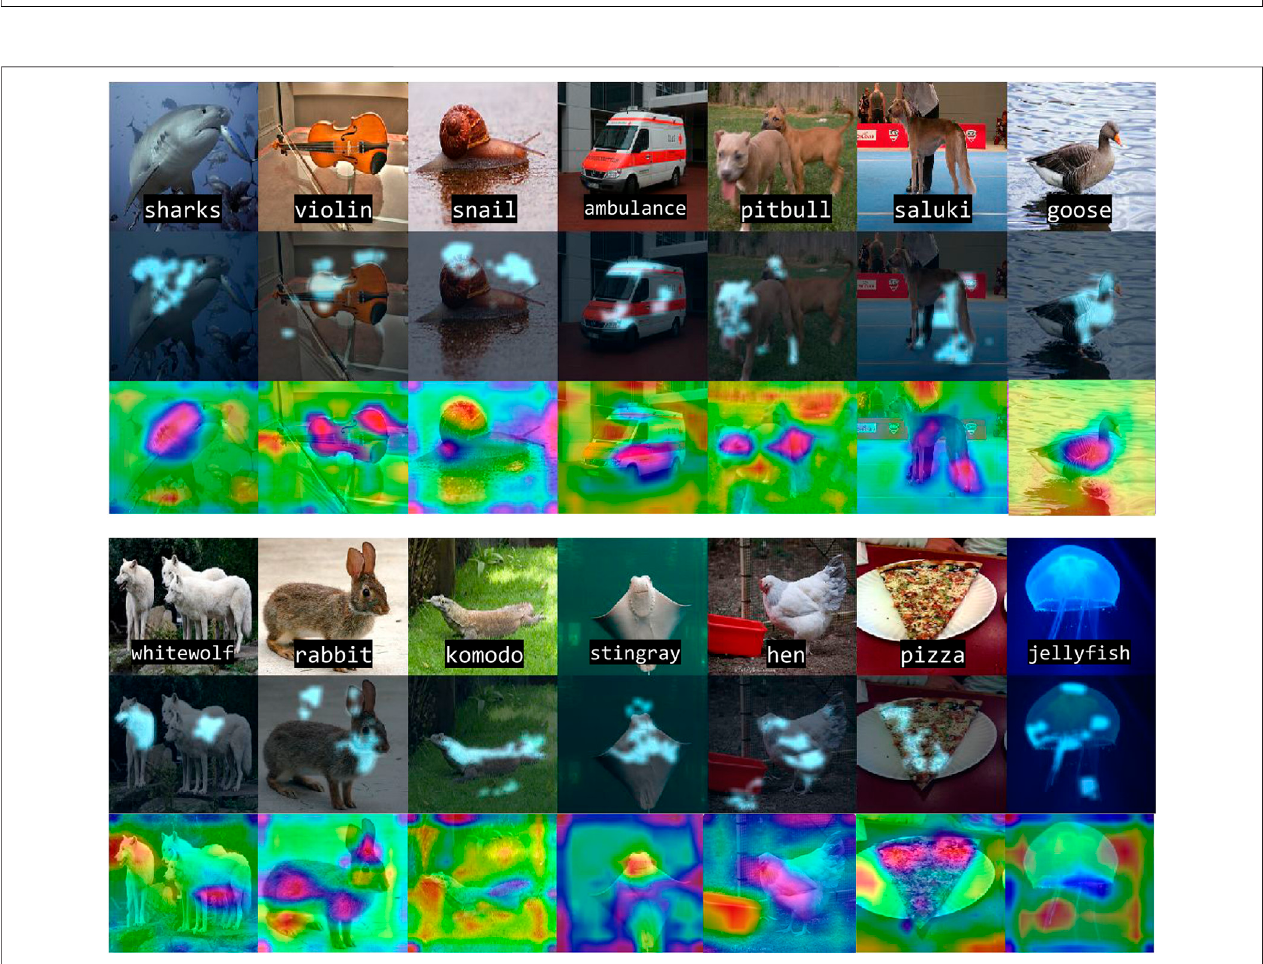
FIGURE 3 | We show the entire process of constructing the saliency map for one particular image (Tabby Cat) from ImageNet. From left to right: original image (dense) saliency map S , sparsity map I , and fi nally the explanation from MARGIN, S final .